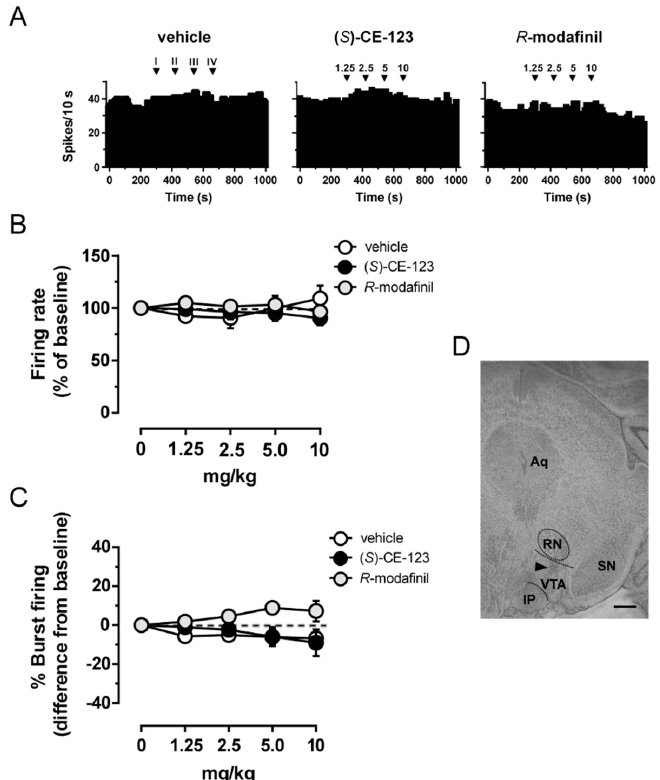
Figure 2. E ff ect of ( S )-CE-123 and R -modafinil on in vivo electrical activity of putative dopamine cells. Representative firing rate histograms of putative ventral tegmental area (VTA) dopamine neurons ( A ) from rats that received cumulative intravenous injections of vehicle (left), ( S )-CE-123 (10 mg / kg; middle) or R -modafinil (10 mg / kg; right). Arrows indicate the time of injections and number of the dose (mg / kg). R -modafinil and ( S )-CE-123 did not change firing frequency ( B ) or bursting activity ( C ) of putative VTA dopamine neurons (vehicle n = 5; R -modafinil n = 6, ( S )-CE-123 n = 7). Symbols and bars represent means ± SEM, RM one-way ANOVA. ( D ) Histological brain section showing the recording site in the VTA. The black triangle indicates the pontamine sky blue dye. Abbreviations: Aq, aqueduct; RN, red nucleus; IP, interpeduncular nucleus; SN, substantia nigra; VTA, ventral tegmental area. Scale bar, 0.5 mm.